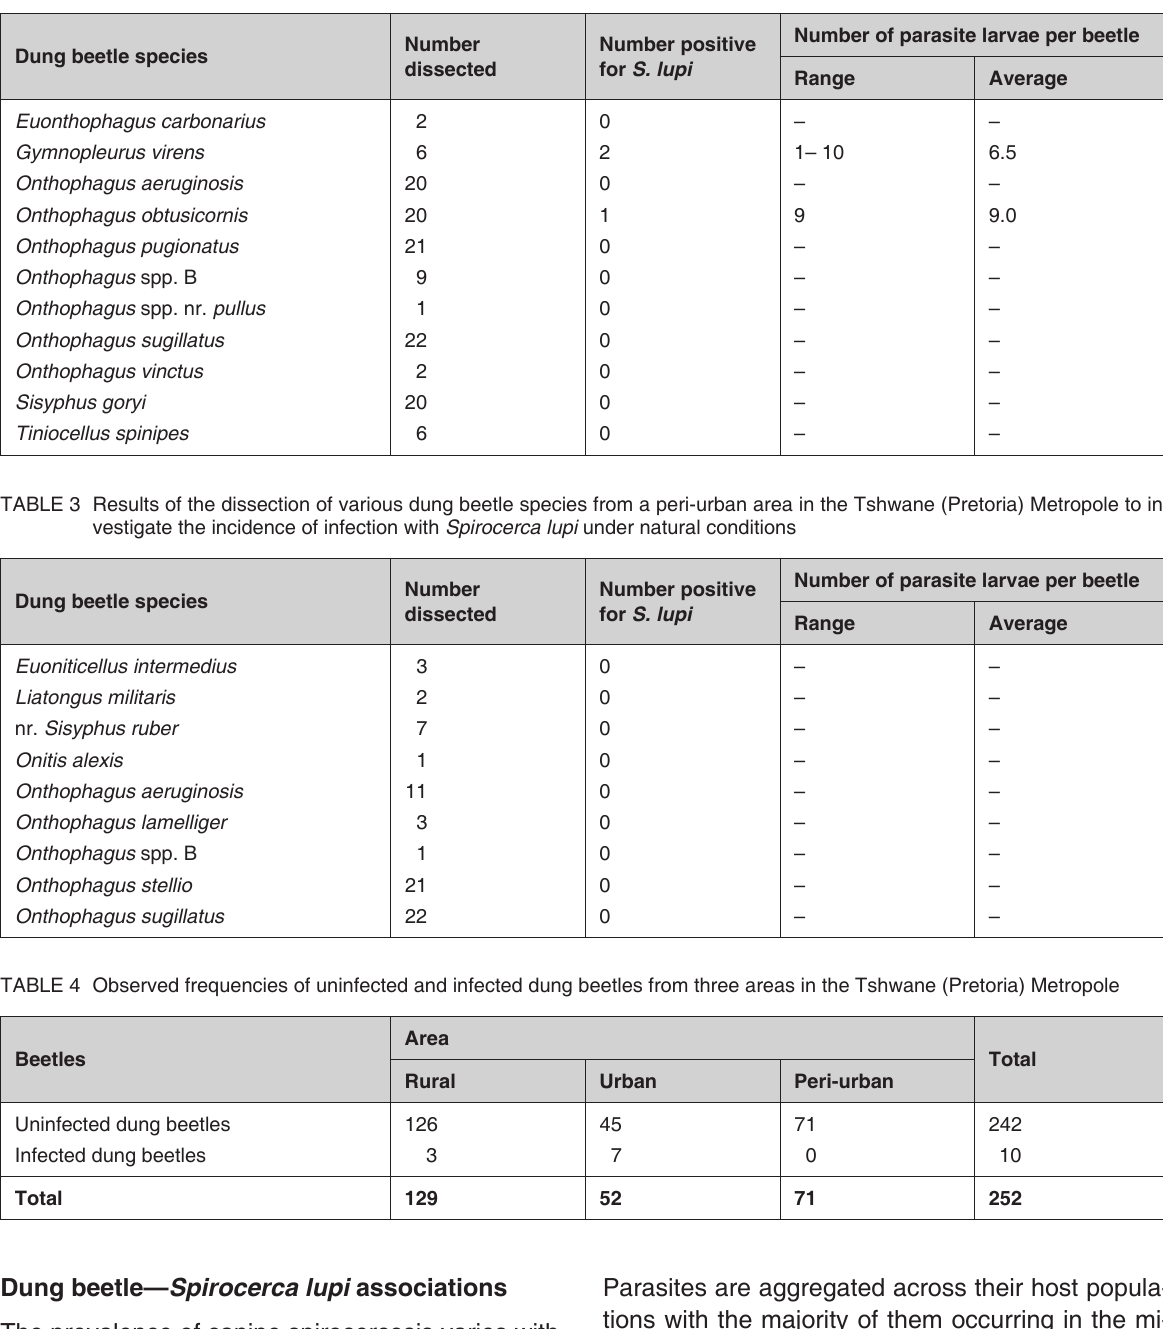
TABLE 2 Results of the dissection of various dung beetle species from a rural area in the Tshwane (Pretoria) Metropole to Investigate the incidence of infection with Spirocerca lupi under natural conditions